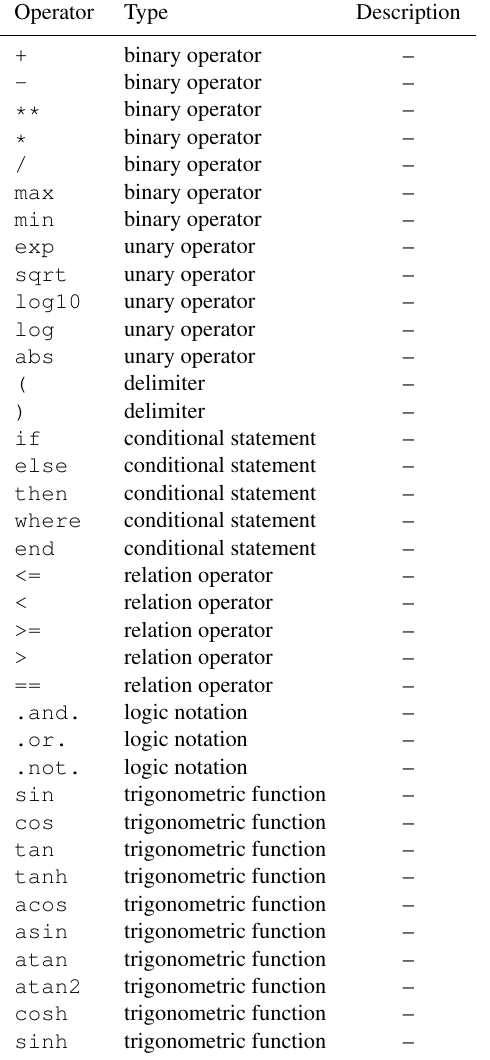
Table E1. Table of operators that can be specified in a string for the property transfer_func in the configuration file mpr.nml . They are directly parsed to the Fortran code.